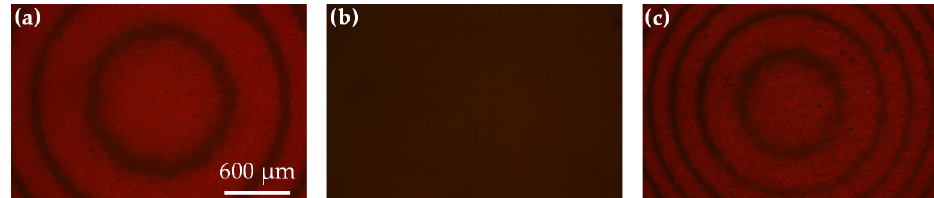
Figure 6. The optical microscopic images for showing the rewriting capability of the ADDCLC sample. ( a ) A Fresnel-like pattern is recorded by the pumping beam with writing intensity of 20 mW/cm 2 for 15 min; ( b ) the pattern is erased by heating at 120 °C for 30 min; ( c ) a different pattern is rewritten by the pumping beam with the same condition of ( a ).